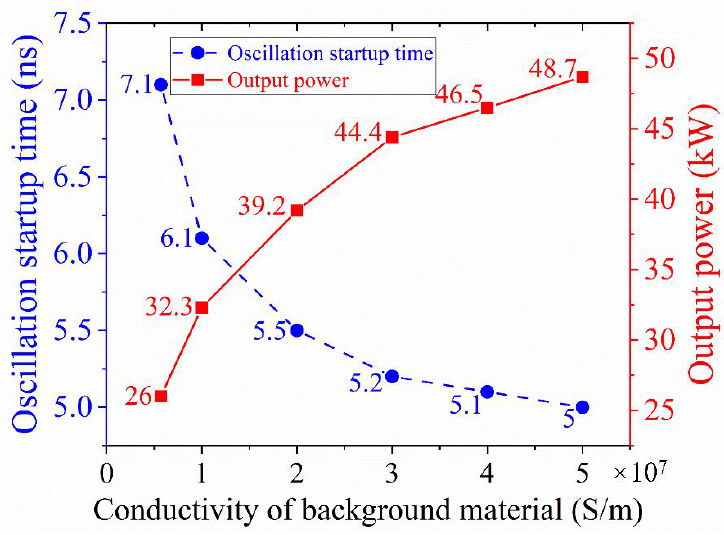
Figure 8. The EIO’s oscillation startup time and output power versus the conductivity of back- ground